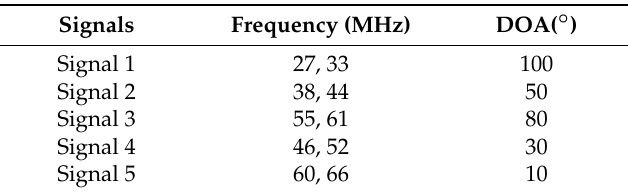
Table 1. The Synchronous FH signals